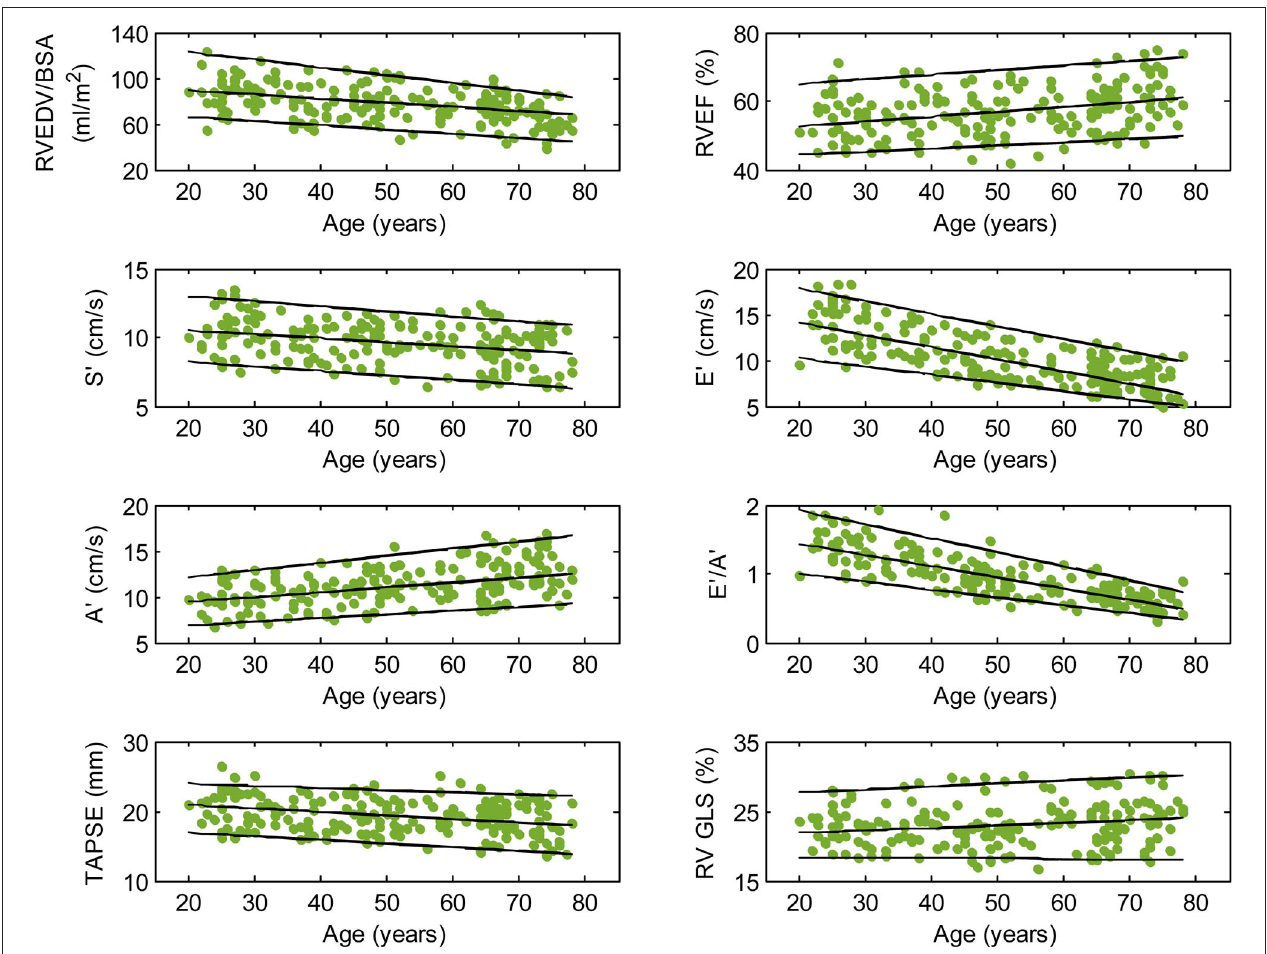
FIGURE 2 | Right ventricular parameters plotted against age in male subjects. (Central line) The 50th percentile; (Top line) The 95th percentile; (Bottom line) The 5th percentile.